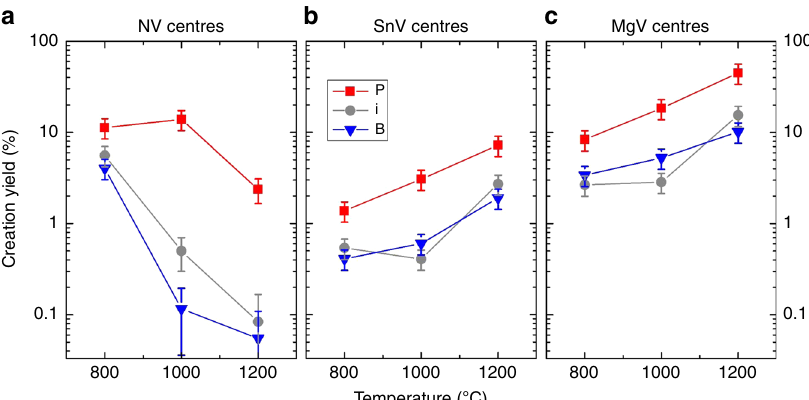
Fig. 5 Temperature evolution of colour centre population. a Creation yield (ratio of NV density and implanted nitrogen fl uence, here 3 × 10 11 cm − 2 ) of NV centres measured after the different consecutive annealing steps of 4 h each and for the different doping conditions. The effective yield enhancement between intrinsic and P-doped diamond is of three at 800 °C, whereas it is of ~ 27 at 1000 °C. b Same graph for SnV centres (Sn fl uence of 3 × 10 11 cm − 2 ). c Same graph for MgV centres (Mg fl uence of 3 × 10 11 cm − 2 ). The error bars represent the measurement uncertainties derived from the yield formula given in supplementary Equation